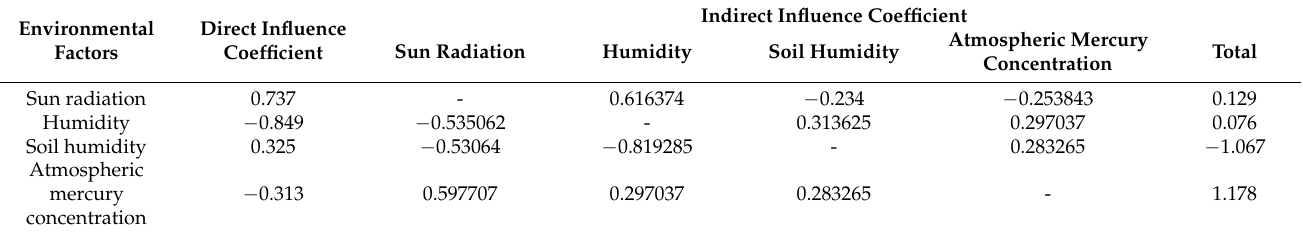
Table 8. Path analysis of the mercury flux and environmental factors during the reproductive stage of L. chinensis . Environmental